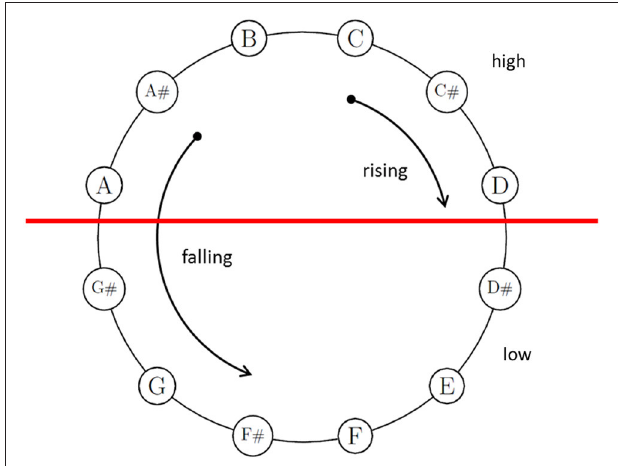
FIGURE 2 | Shepard tones arranged in the pitch-class circle. Tritone paradox: Shepard tones in the upper half ( A , A # , B , C , C # , D ) are judged as higher than those of the lower half ( D # , E , F , F # , G , G # ). Proximity principle: When the distance between two pitch classes is clockwise shorter than counter-clockwise, participants prefer rising judgments; in the opposite condition, participants prefer falling